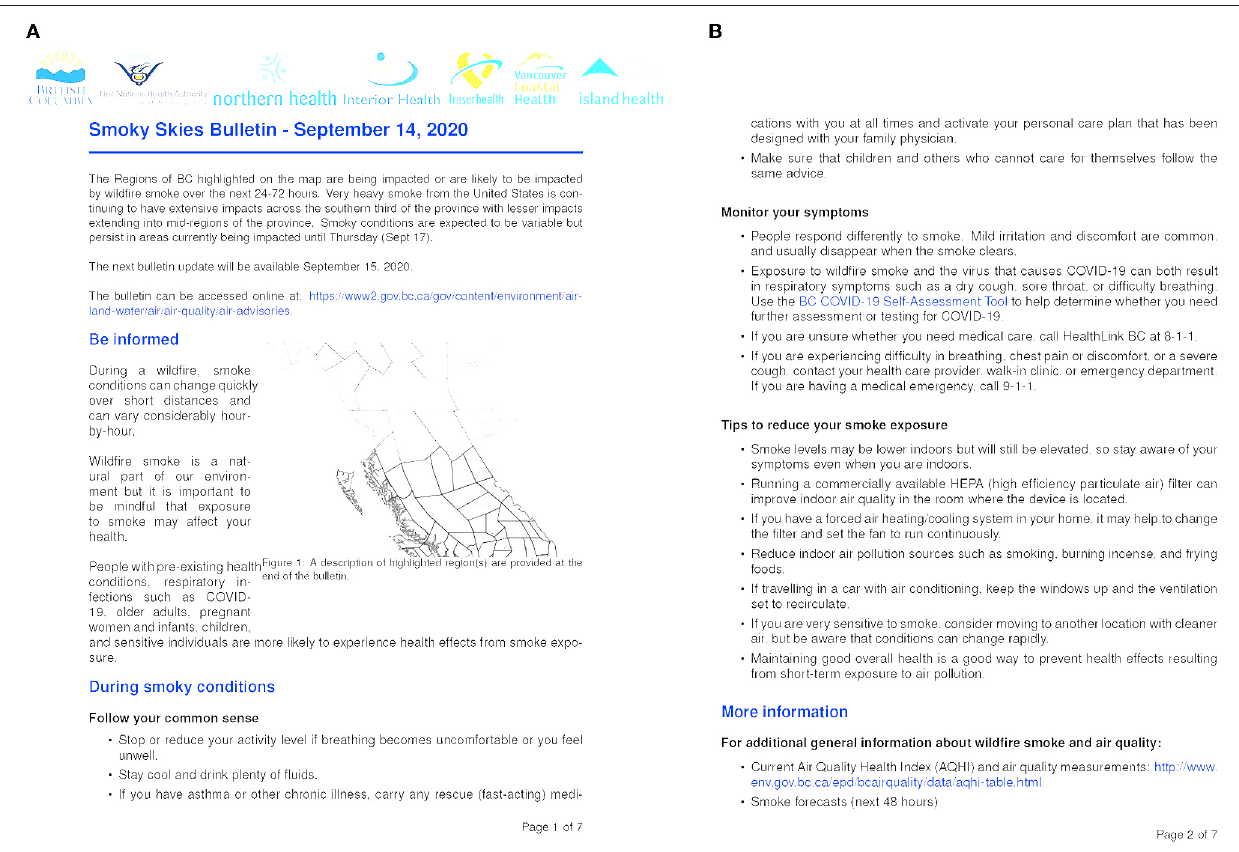
FIGURE 1 | Smoky Skies Bulletin from September 2020 with (A) air quality information and (B) health